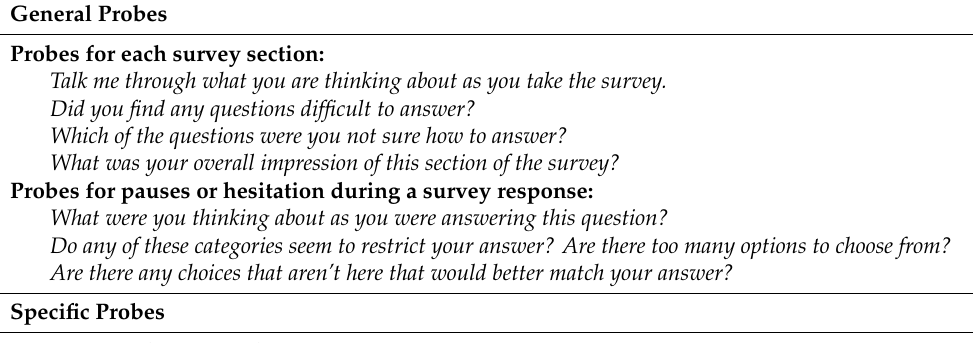
Table 1. Examples of general and specific probing questions to assess readability, interpretability, and comprehension of survey